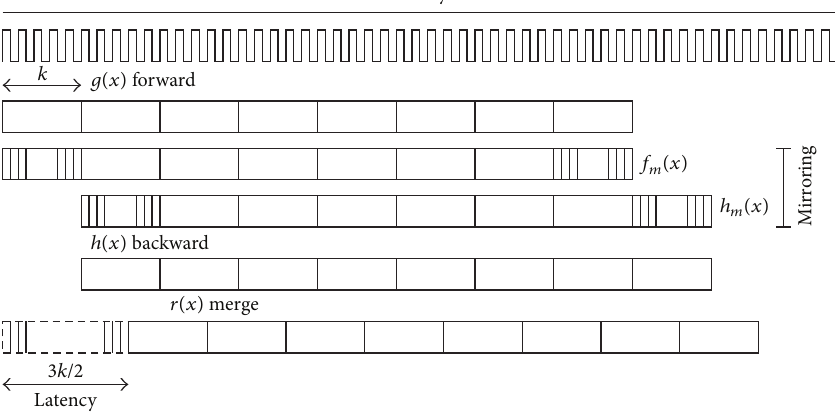
Figure 3: Pipeline scheme used in the HGW architecture. The computations and data flow are organized around a three-stage pipeline, forward, backward, and